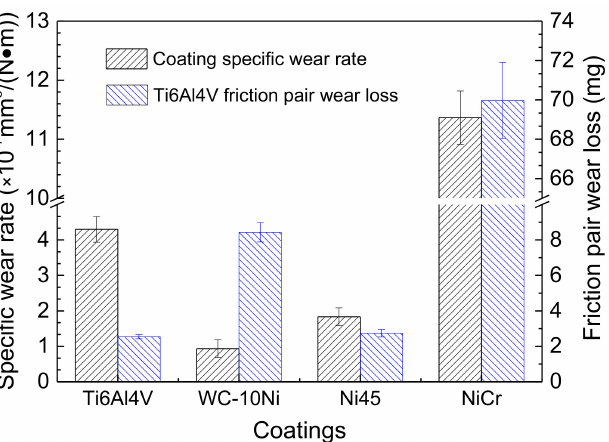
Figure 10. The specific wear rate of the coatings and the wear loss of the Ti6Al4V friction